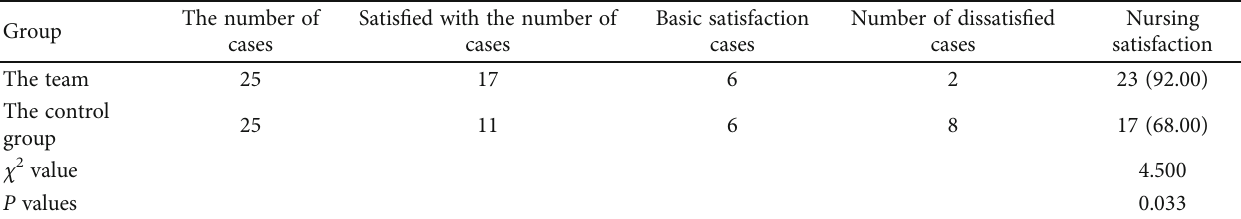
Table 2: Comparison of nursing satisfaction between the two groups. Group